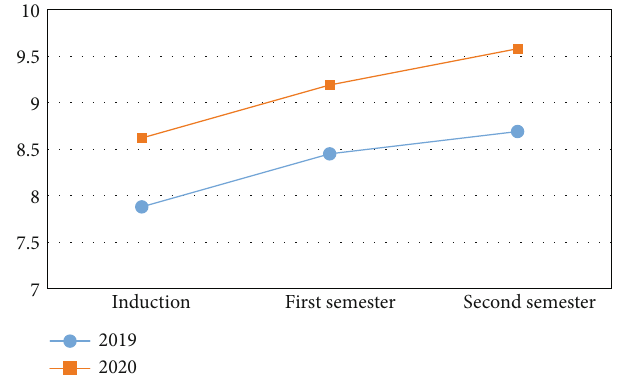
Figure 5: Comparison of students ’ aerobic teaching results and employers ’